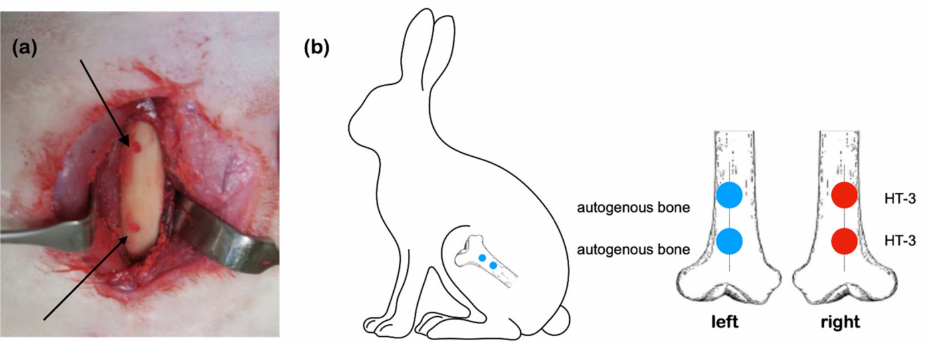
Figure 1. ( a ) Surgical model and ( b ) a schematic implantation design in the right distal femur of